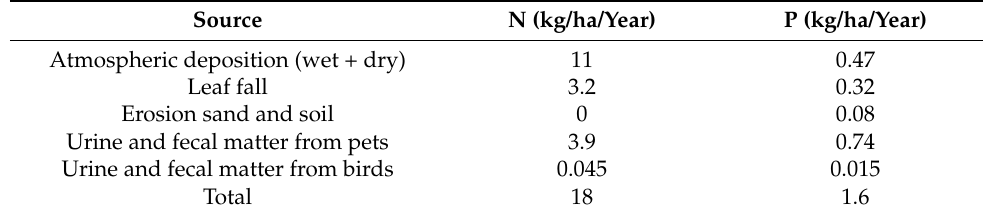
Table A4. Emission factors for TN and TP, taken from reference [36].